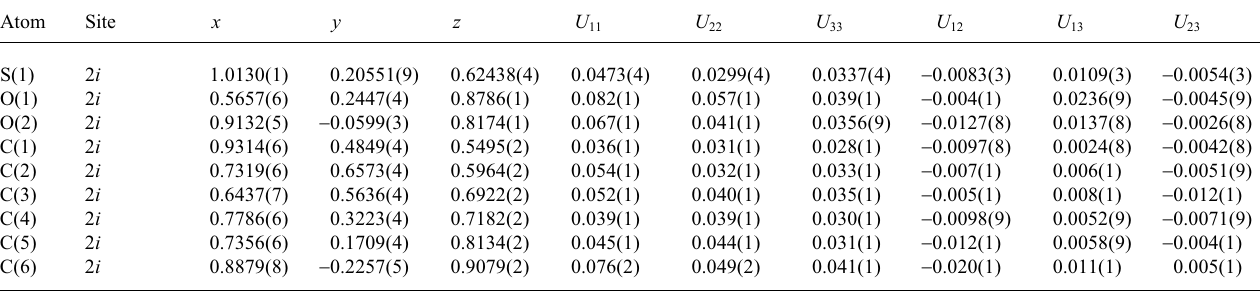
Table 3. Atomic coordinates and displacement parameters (in Å 2 )